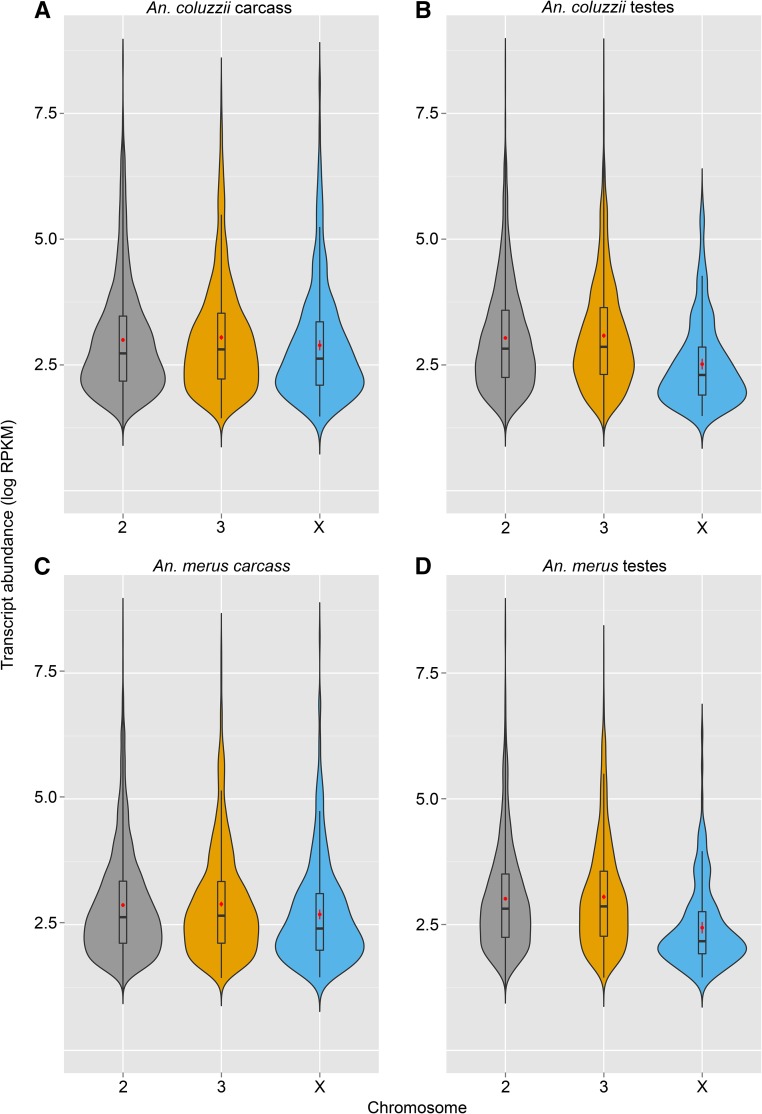
Transcription of the X chromosome is repressed in Anopheles testes (A–D). Violin plots show the density (represented by width) of transcript abundances (log RPKM) of all genes located on the 2, 3, and X chromosomes. Within each violin plot is a box plot that shows median, 25th, and 75th percentile values of transcript abundance (±SD). Within each box plot, a red dot denotes the mean transcript abundance (±SEM). All visualizations support X-specific silencing in the male germline, but not soma, of both species.